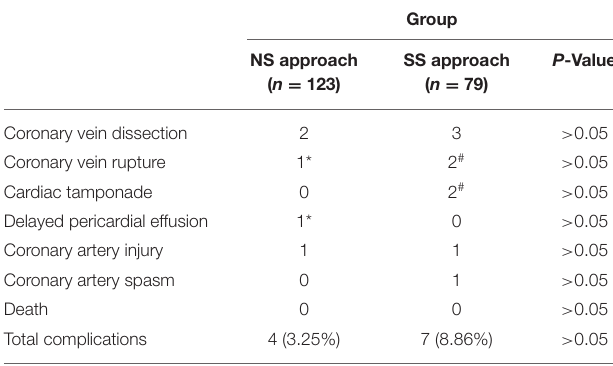
TABLE 4 | Comparison of complications between these two manipulation methods